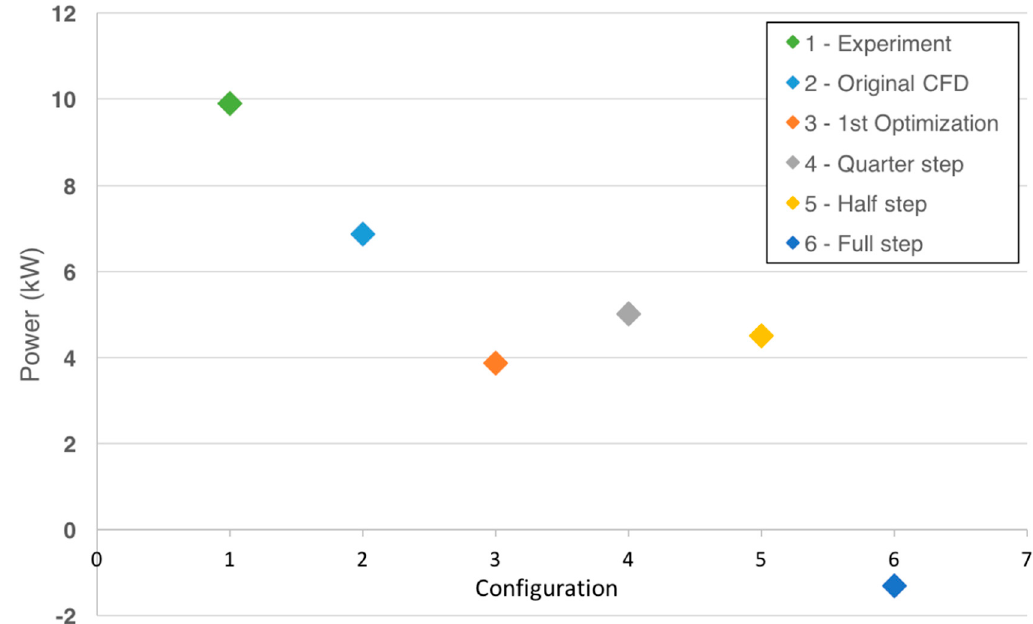
Figure 26. Power output of the turbine for different twist angle distributions.